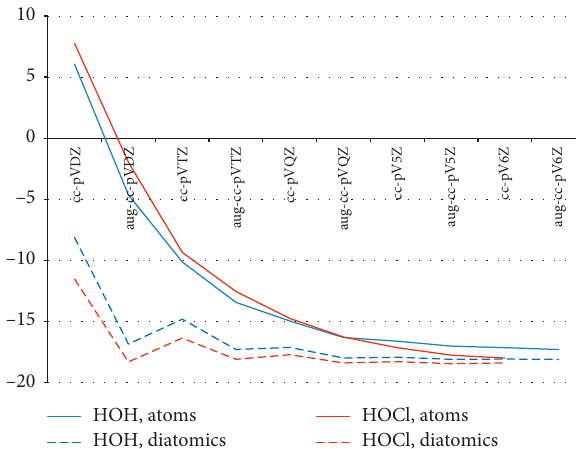
Figure 7: Convergence of the CCSD(T) standard enthalpies of formation of H 2 O and HOCl (in kcal/mol) obtained from the atomization reaction and the decomposition toward the diatomics. The values for water have been shifted upwards by the difference between the experimental enthalpies of formation 39.7